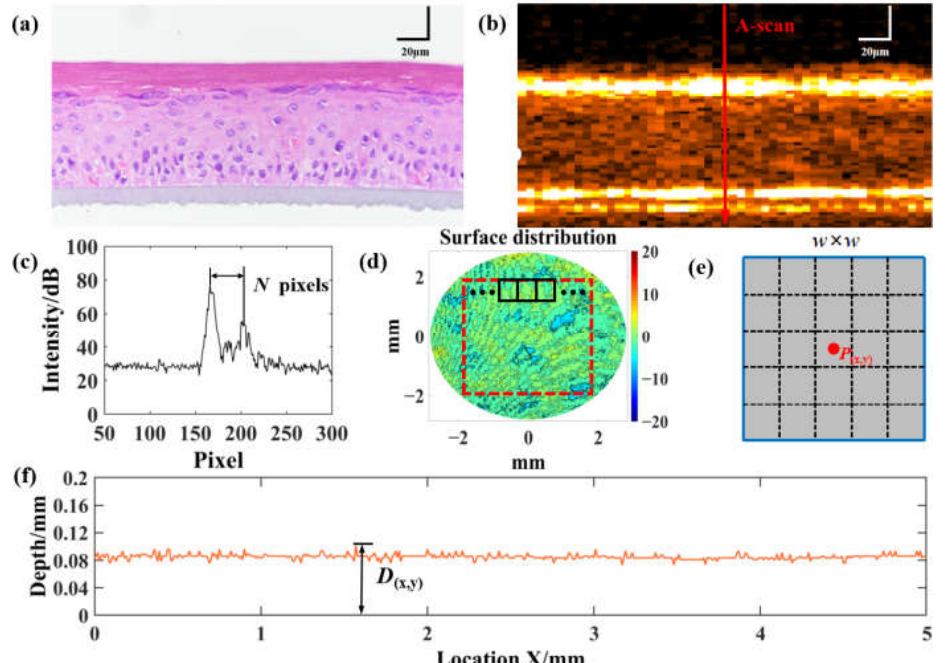
Figure 2. AS intensity signal analysis. ( a ) H&E staining for Group 4. ( b ) OCT intensity image. ( c ) OCT interferometric signal in ( b ). ( d ) AS 2D surface profile image. The area surrounded by the red border is the ROI. The area surrounded by the black border is the sliding average window. Sliding window method for calculating roughness of AS. ( e ) The size of the window is w pixel × w pixel. The center pixel point of the window is (x,y) and the average roughness inside the window is s (x,y) . The roughness of the central pixel point P (x,y) is set to the average roughness within the window. ( f ) Image of 2D thickness distribution.